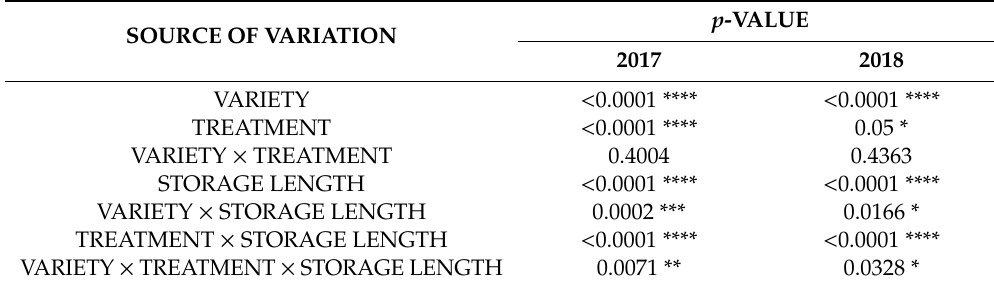
Table 1. Analysis of variance (ANOVA) table for monthly weight loss.